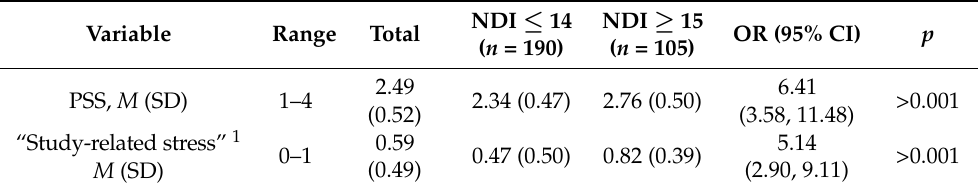
Table 2. Distribution of stress for the total sample and by NDI ( N =